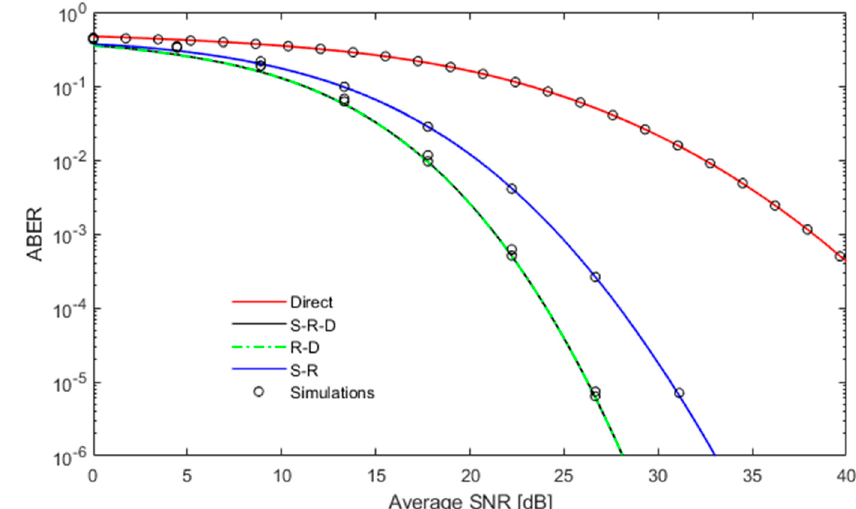
Figure 16. ABER vs. SNR of FSO over L-N channel for moderate turbulence with distance 400–600 m, the number of relays = 2, and wz = 2 m.